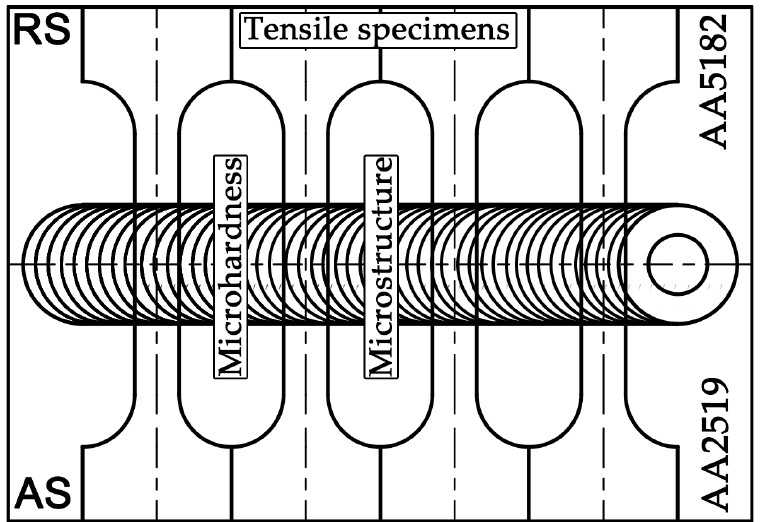
Figure 1. The schematic showing the orientation of tensile test specimens’ relative weld path.